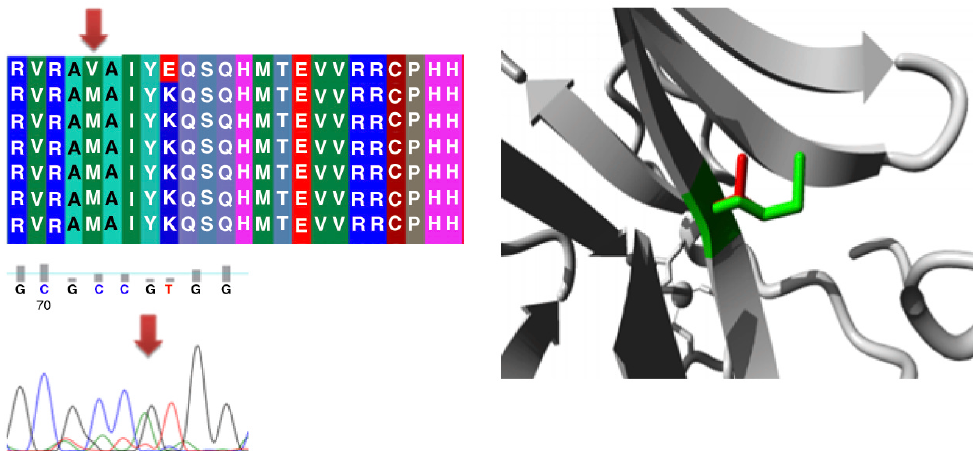
298.Figure 7. Mutation of a methionine into a valine at position